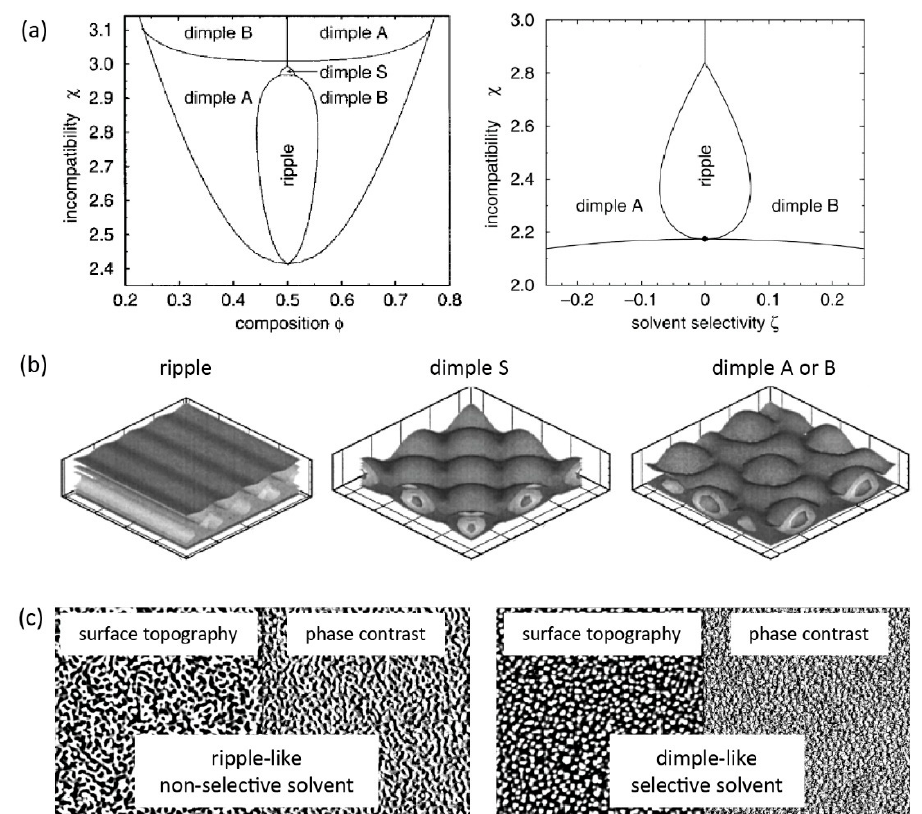
Figure 5. ( a ) Left: phase diagram as a function of incompatibility, χ , and composition, ϕ , of two polymers. Right: phase diagram as a function of incompatibility, χ , and solvent selectivity, ζ . ( b ) 3D illustration of “ripple”, symmetrical “dimple S”, and “dimple A or B” nanostructures from simulation results. ( c ) Atomic force microscopy (AFM) tapping mode images (5 × 5 µ m 2 ) of polystyrene (PS) / poly(methyl methacrylate) (PMMA) mixed brush after exposure to different solvents. (Adapted with permission from Reference [88], Copyright 2002, American Physical Society and Reference [153], Copyright 2002, American Physical